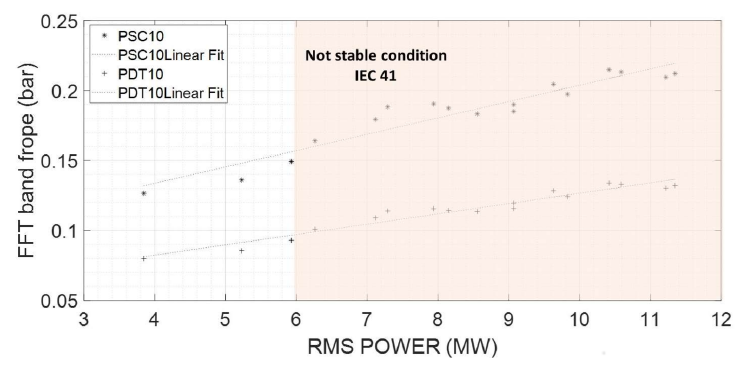
Figure 16. Optimized acquisition strategy. Correlation of indicators.